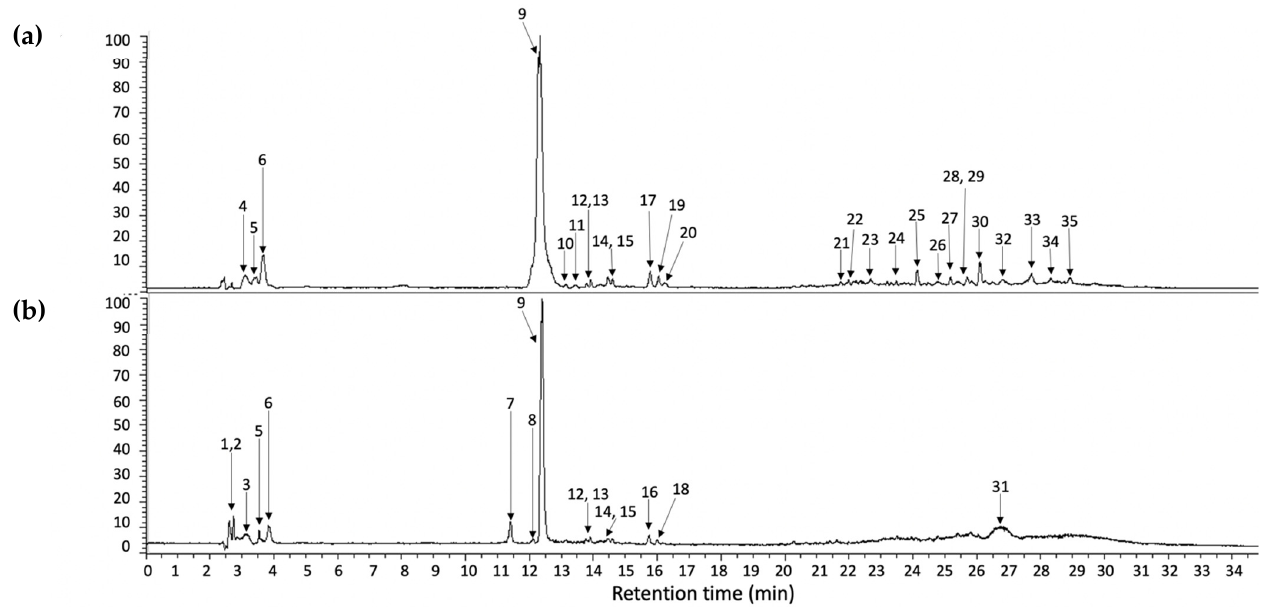
Figure 2. UHPLC chromatogram integrated at 254, 280, 320, and 440 nm of cooked ( a ) and crude ( b ) samples prepared from A. tetragonus . The peak numbers refer to those metabolites indicated in Table 1. The same numbers in “( a , b )” refer to metabolites found in both samples.